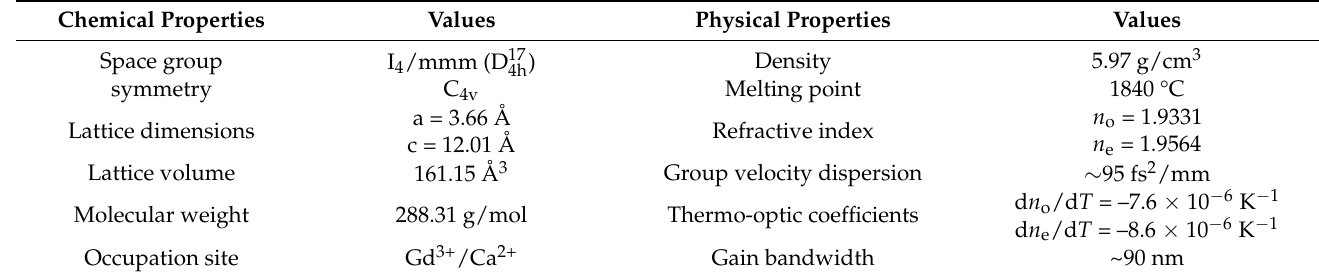
Table 1. Chemical and physical properties of Yb:CALGO